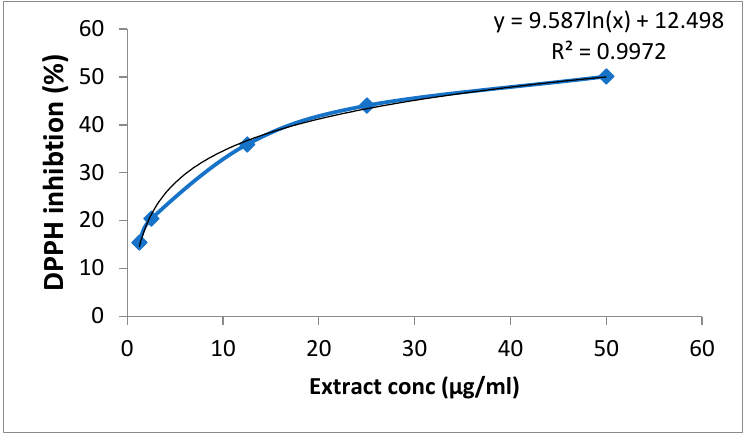
Figure 3. Percentage inhibition of the DPPH radical scavenging activity of phlorotannins extracted from S. linifolium brown alga.